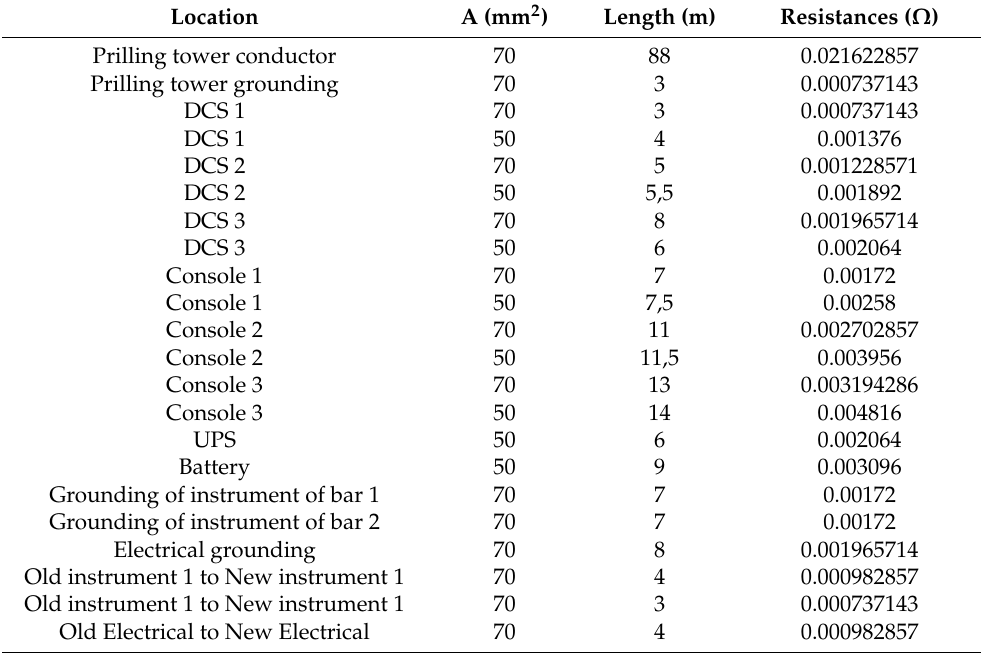
Table 2. Data of grounding cables and conductors.